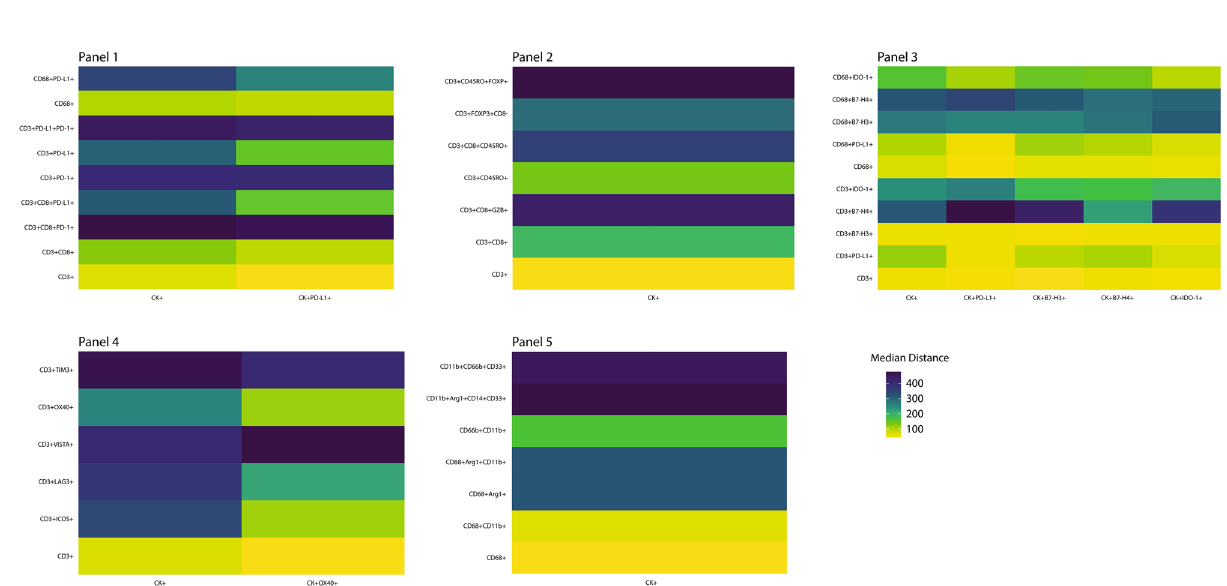
Figure 6. Heatmaps characterizing the median proximity from CK+ malignant cells and malignant cells expressing different immune checkpoint markers according the multiplex immunofluorescence panels. The images were generated using R studio software version